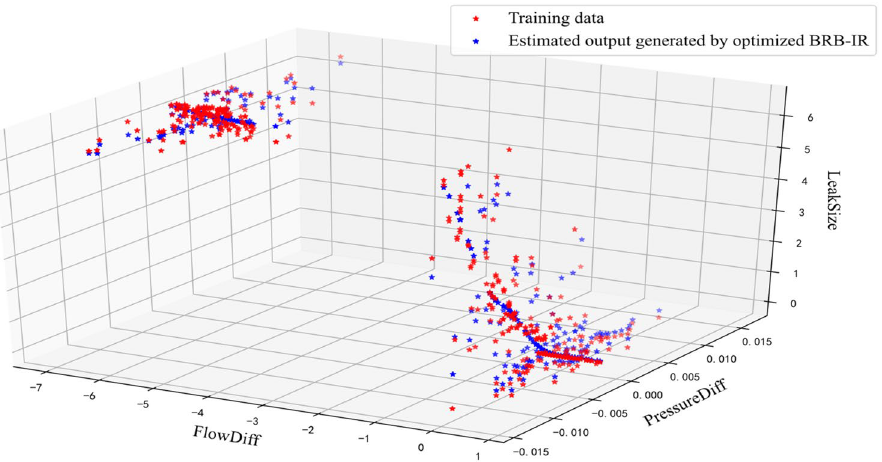
Figure 6. Estimated output of the optimized BRB-IR.